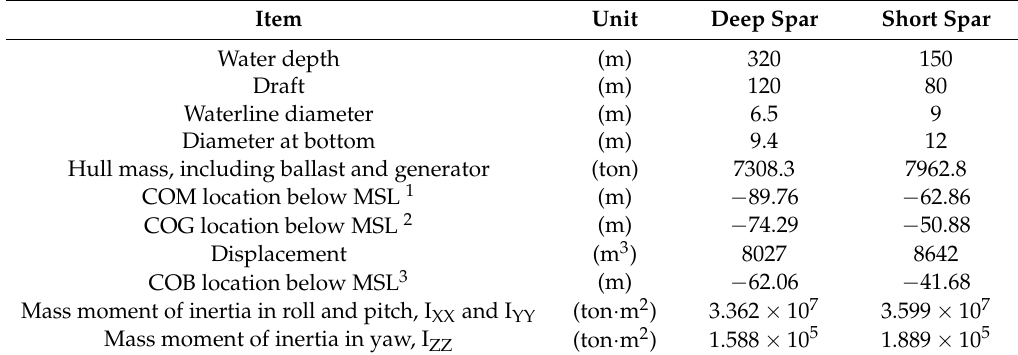
Table 2. Properties of the Deep Spar and Short Spar.